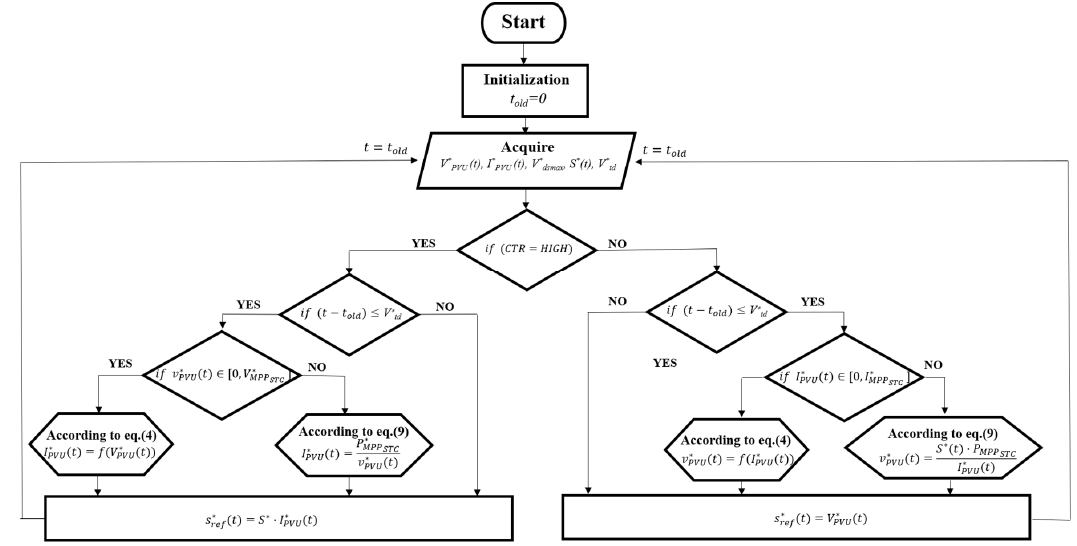
Figure 9. Flowchart of routine written in Arduino code.